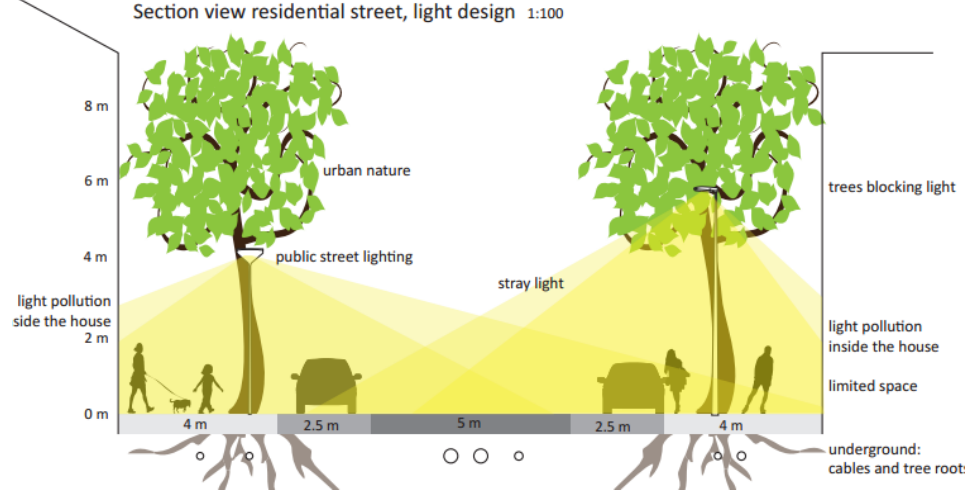
Figure 1. Conflict between residential street lighting systems and trees: the power cables are entangled in the roots.